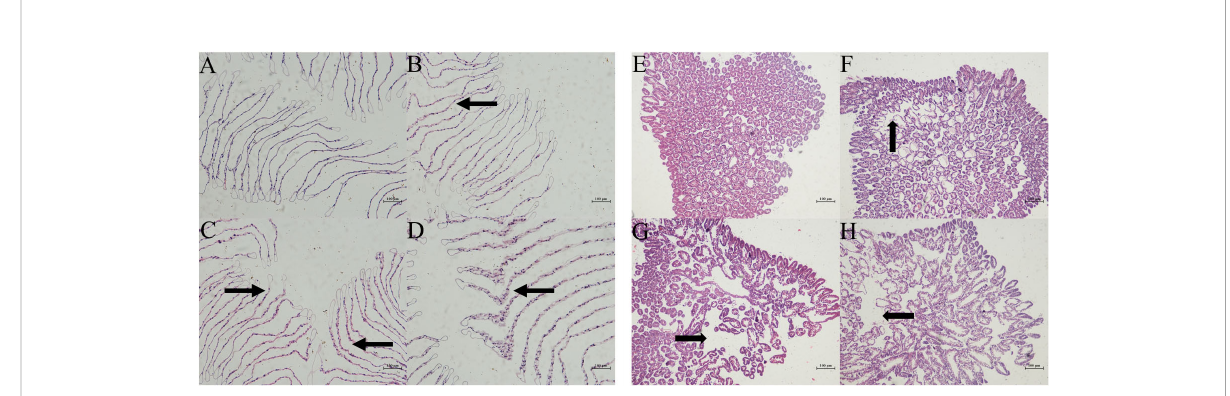
FIGURE 3 Histological observation of the gills ( A : 0 ppt, B : 7 ppt, C : 14 ppt, and D : 21 ppt) and hepatopancreas ( E : 0 ppt, F : 7 ppt, G : 14 ppt, and H : 21 ppt) by H&E staining in M. nipponense . The histological differences were tagged (by thin arrows and arrowheads).